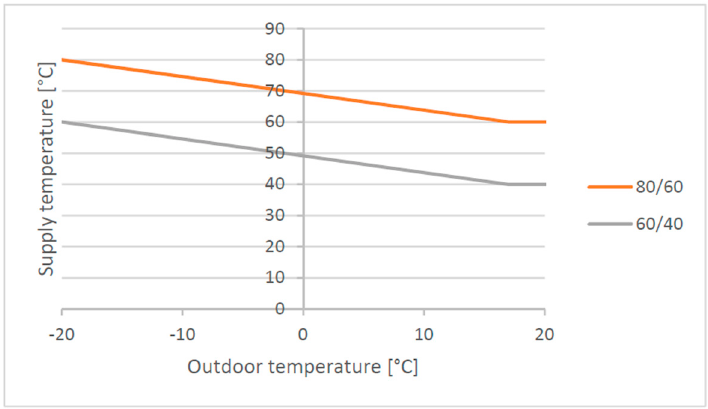
Figure 2. Weather compensation curves for the supply temperature of the two radiator systems with dimensioning temperature levels 80/60 and 60/40 °C.